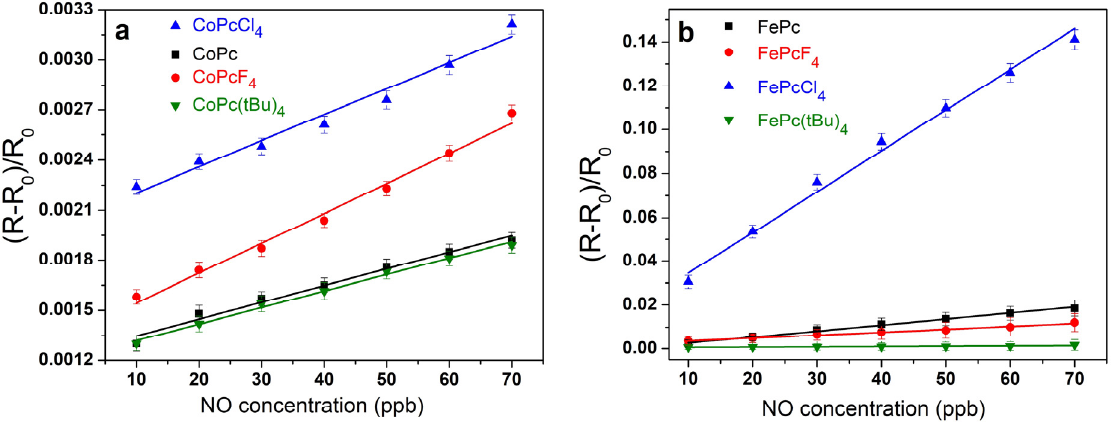
Figure 8. Dependence of the sensor response of CoPcR 4 ( a ) and FePcR 4 ( b ) (R = H, F, Cl, tBu) films on NO concentration (10–70 ppm).